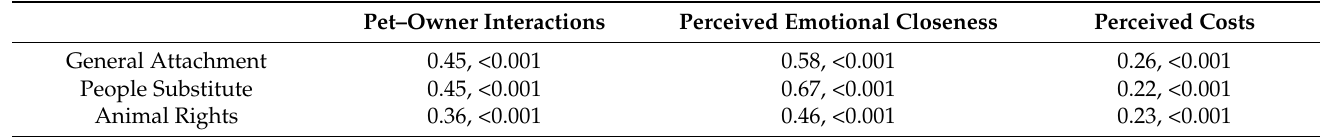
Table 5. Spearman’s correlations between LAPS and C/DORS (Spearman rho, p values).